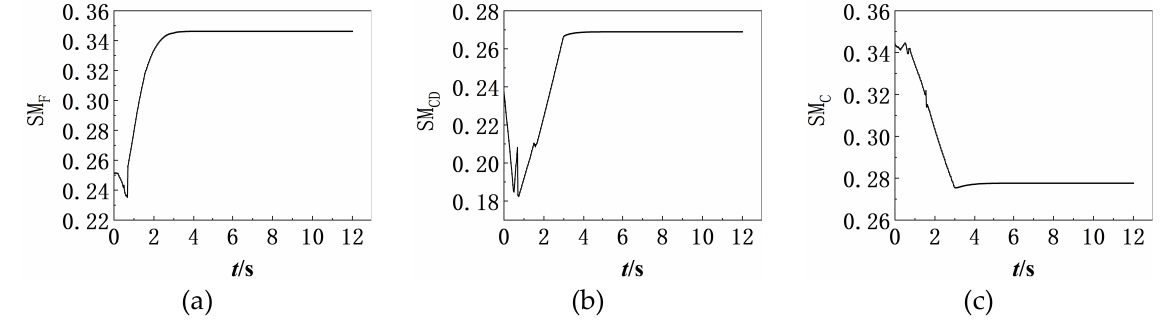
Figure 16. Change curves of surge margin of working-mode switching from single bypass to double bypass at H = 0 km, Ma = 0. ( a ) Surge margin of fan; ( b ) surge margin of CDFS; (c ) surge margin of HPC.